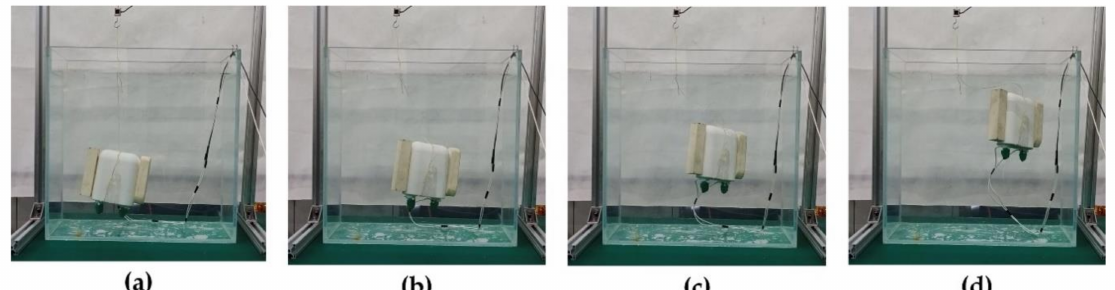
Figure 15. The phase-change BCM is driven by the buoyancy to control the rise and suspension in the tank: ( a ) initial state (tension shown by force sensor is 4.5 g); ( b ) buoyancy is greater than zero, and it starts to rise; ( c ) stop heating and hover in the water; ( d ) continue heating and rise to the surface.